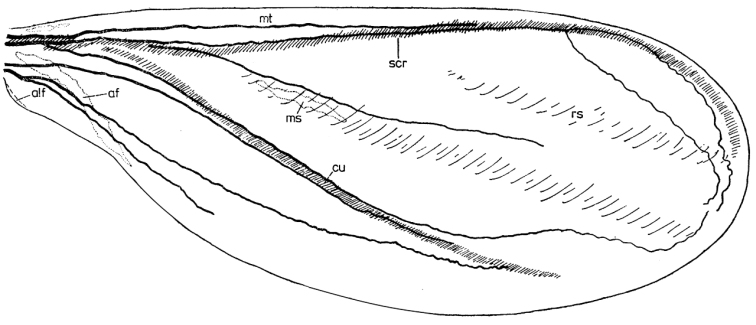
Tracheal system of forewing of Orthezia
urticae (Linnaeus 1758) after Koteja (1986).